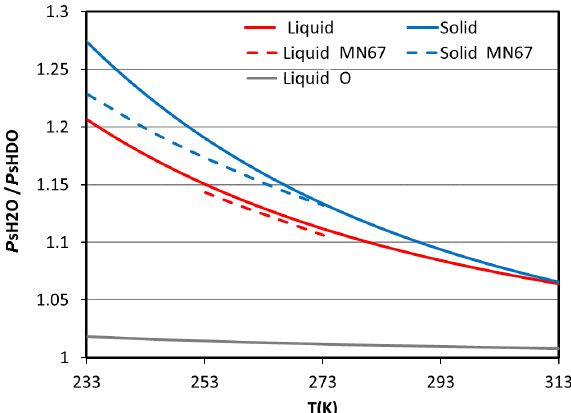
Figure 2. The ratio between saturation pressure of H 2 O and HDO in different phases (liquid: red line, solid: blue line) at different tem- peratures. The grey line is the ratio of 18 O based on Horita and Wesolowski (1994). The dashed lines are the formulas from Merli- vat and Nief